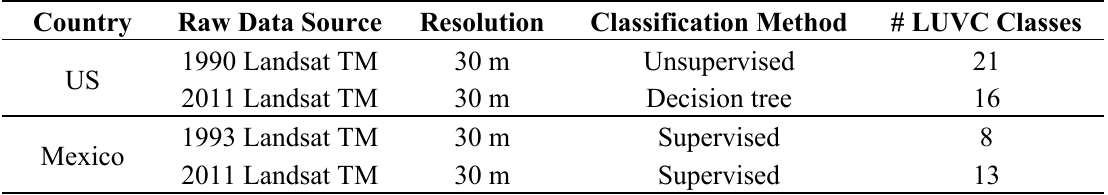
Table 1. Source and specifications of input data for Land Use and Cover Change (LUCC) analysis.